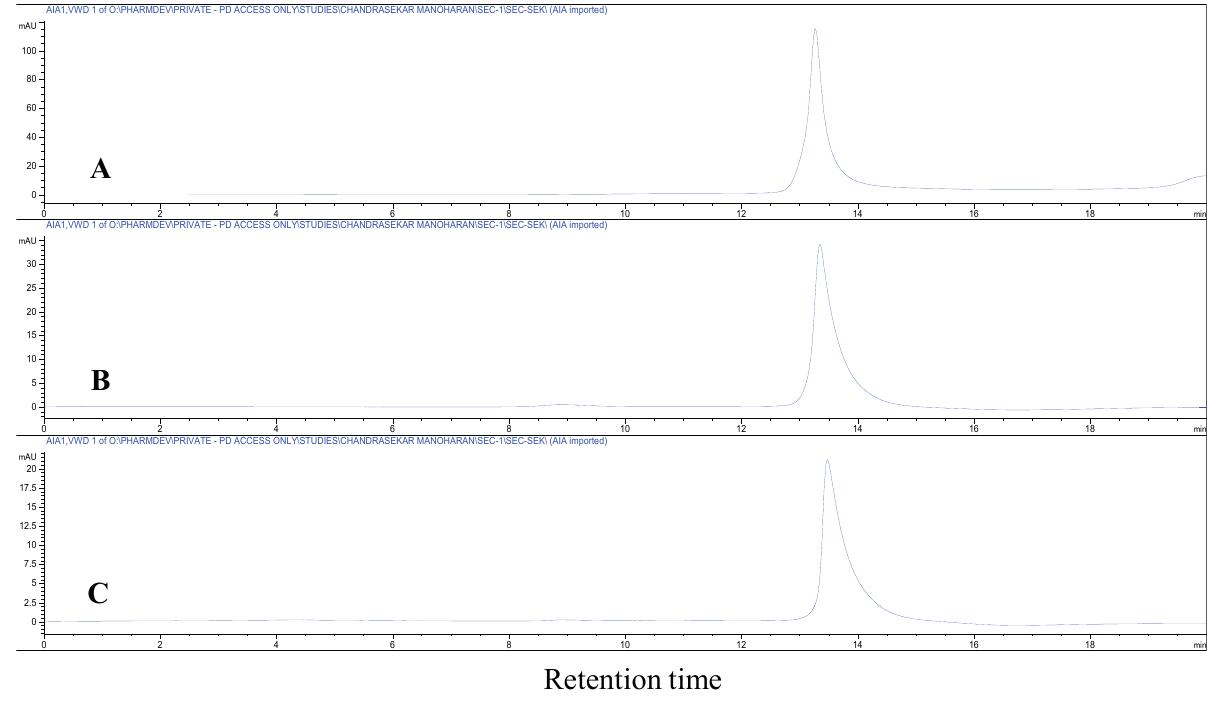
Figure 4. Size exclusion high performance liquid chromatography (SE-HPLC) chromatograms of ( A ) native insulin; ( B ) insulin precipitates obtained after homogenization at 10,000 rpm; and ( C ) insulin precipitates with added zinc after homogenization at 10,000 rpm. The precipitates were dissolved in 0.5% sodium dodecyl sulfate (SDS) aqueous solution prior to analysis.